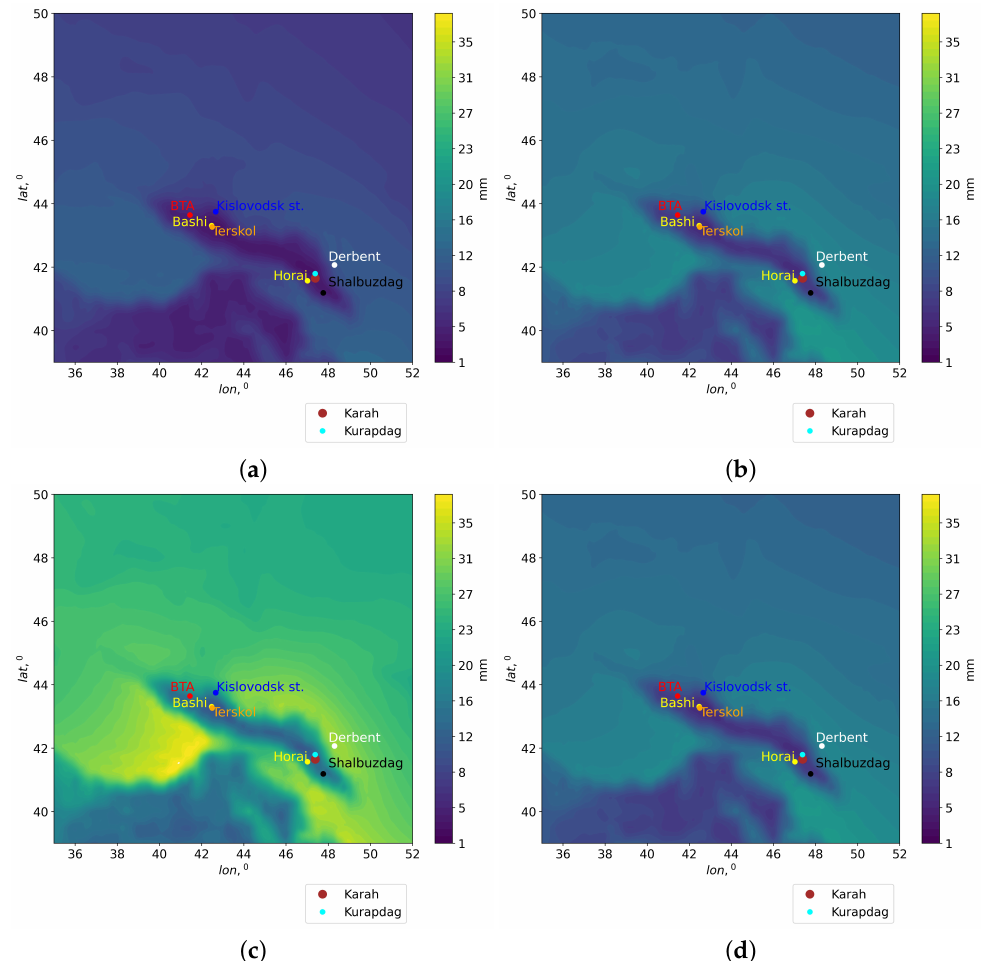
Figure 5. Spatial distributions of PWV 0 obtained from Era-5 reanalysis data for the period 2010–2020: ( a ) winter; ( b ) spring; ( c ) summer; ( d )